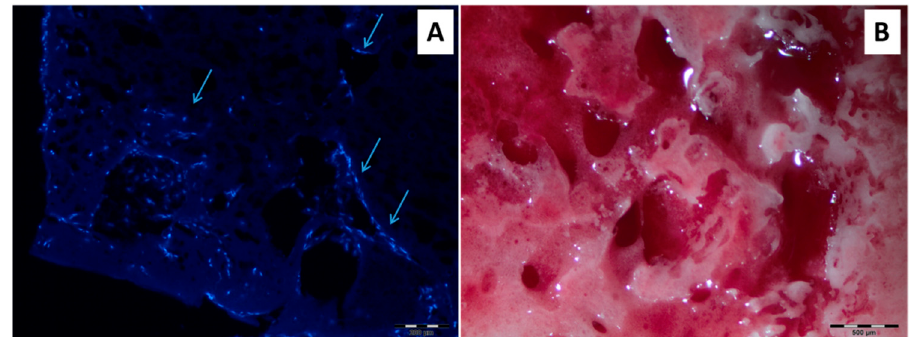
Figure 11. Results of one-month dynamic cultivation of MSC on modified PLA materials: ( A ) DAPI-stained slice (cells ingrowth into the material is marked with arrows), ( B ) matrix was stained with alizarin red (red color detects the calcification process).